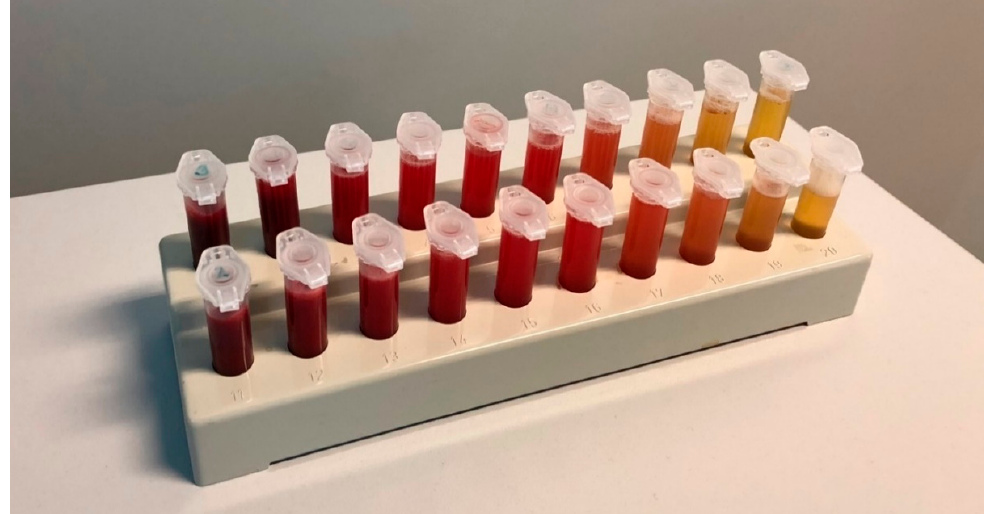
Figure 1. Dilution series. Blood-ascites mixtures ranging from 1:1 (left hand side) to 1:1024 (right hand side). hand